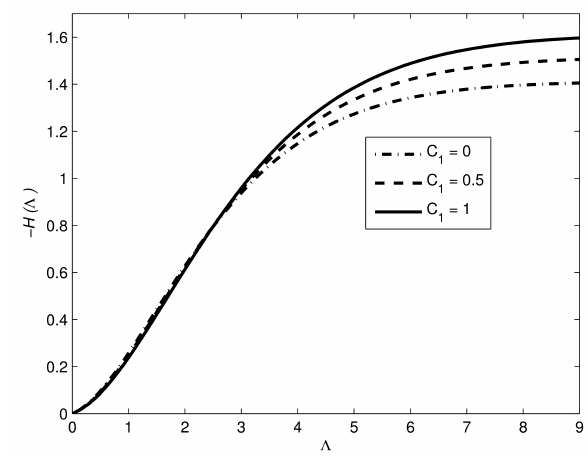
Figure 2: Effect of C 1 on F ( Λ ) keeping ζ = η = 0.2 , C 2 = C 3 = 1 , Pr = 6.8 , Br = 1 and Re = 2950